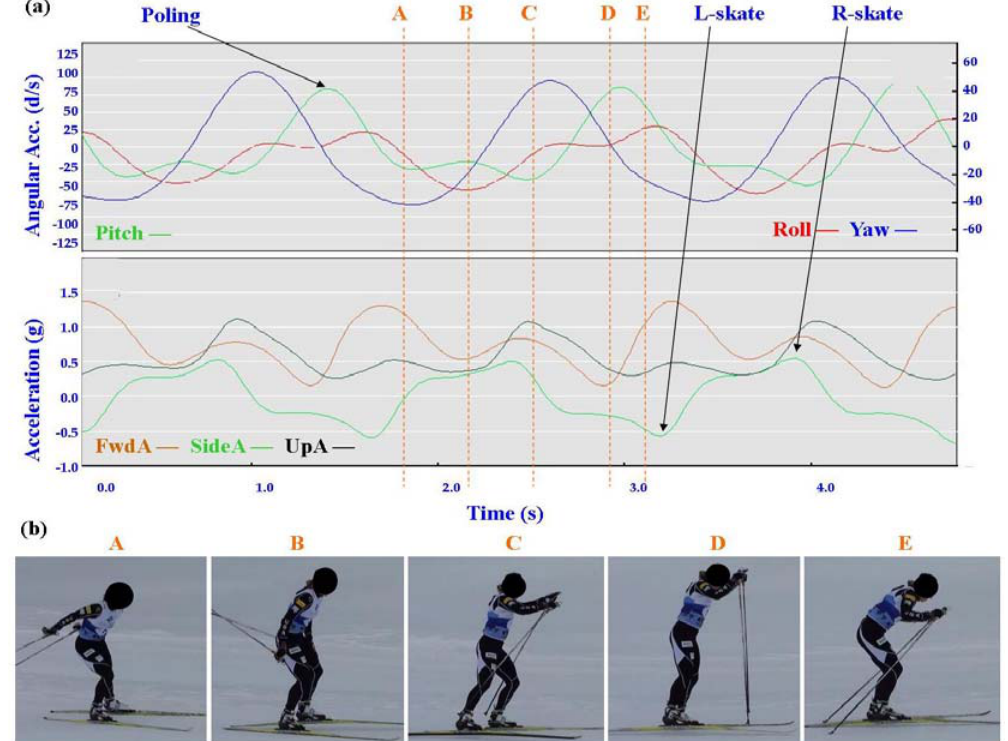
Figure 8. ( a ) Screenshot of Single Time (G4) gyroscope and accelerometer traces against time; ( b ) G4 body position for selection points.